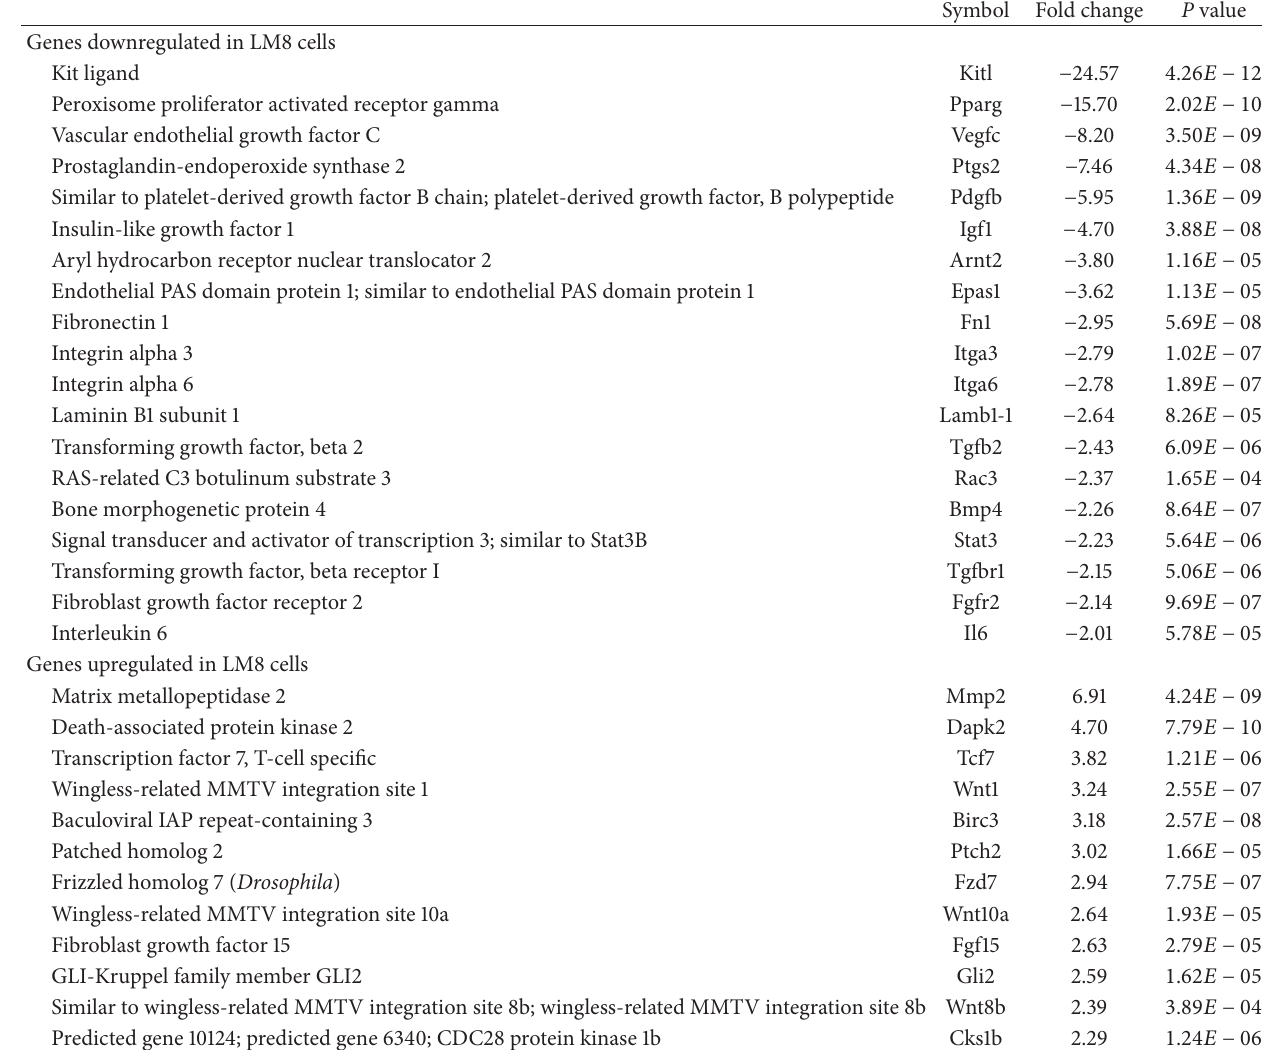
Table 2: Genes involved in cancer pathways (KEGG pathway; DAVID) and whose expression is significantly down- or upregulated in LM8 compared to Dunn